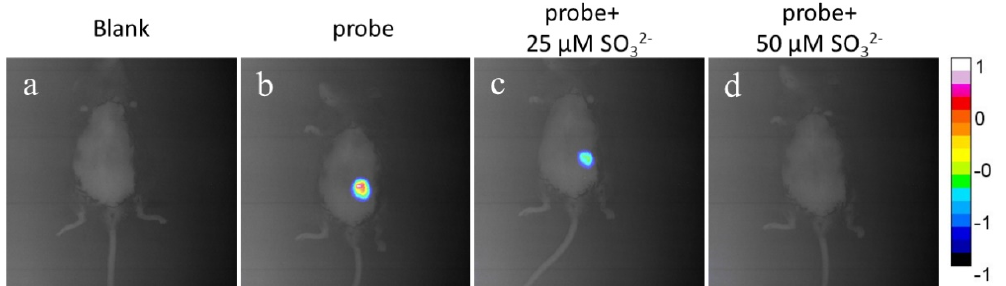
Figure 5. Fluorescence images of IPB-RL-1 in zebrafish (( a − d ): the control group; ( e − h ): zebrafish incubated with IPB-RL-1 only; ( i − l ): zebrafish incubated with IPB-RL-1 for 1 h and then SO 32 − for 30 min; λ ex : 405 nm; blue: λ em = 420–520 nm; red: λ em = 700–800 nm).